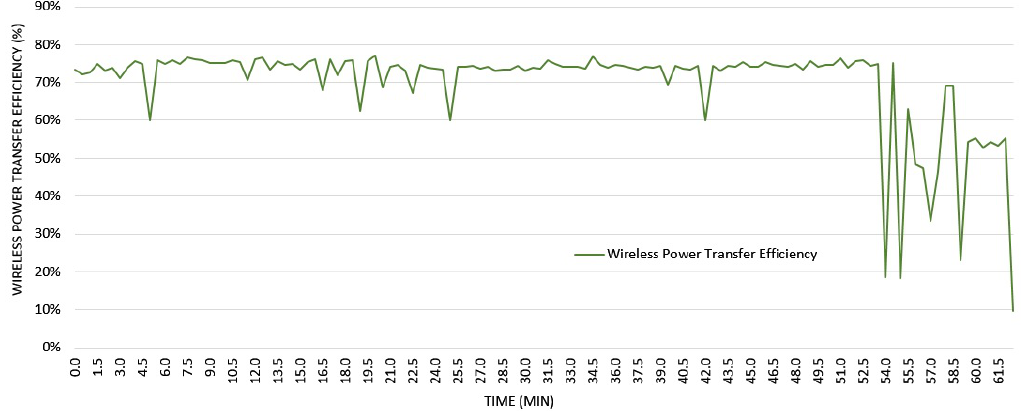
Figure 14. Wireless power transfer efficiency during charging.